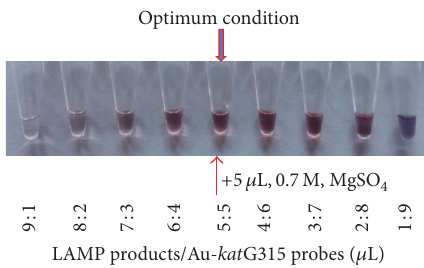
Figure 5: Determining the optimal condition of hybridisation for Au-nanoprobe assay.